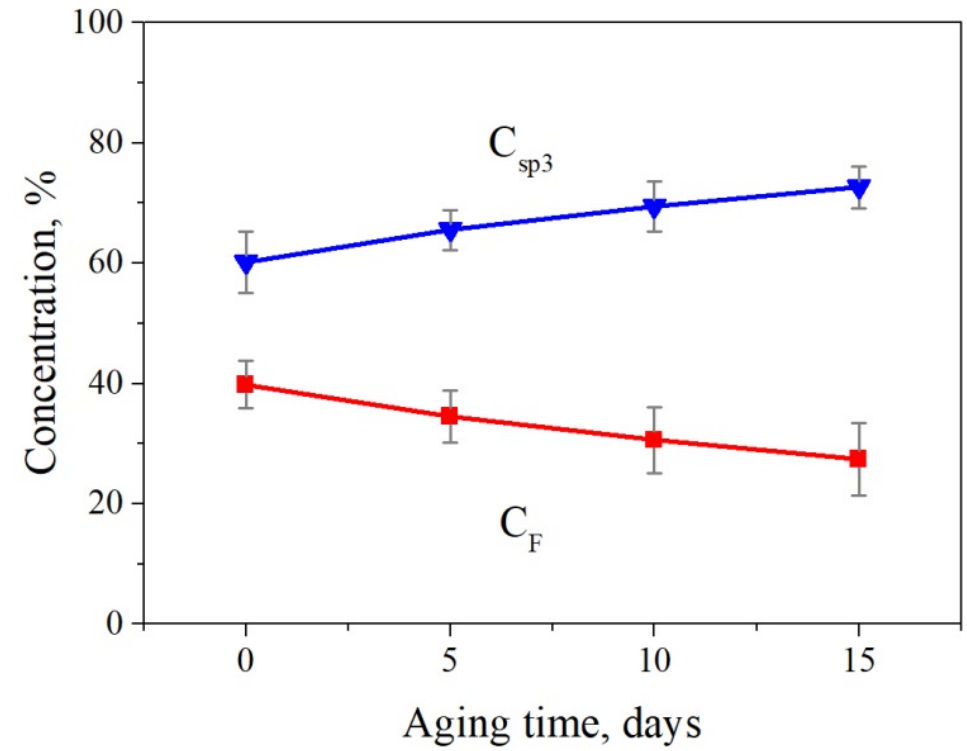
Figure 3. The concentrations of sp 3 bonds C sp3 and C–F bonds C F plotted with the aging time. It can be clearly seen that there is an increase of sp 3 intensity after aging as a consequence of the accumulation of hydrocarbon, and the corresponding F bonds decrease accordingly.